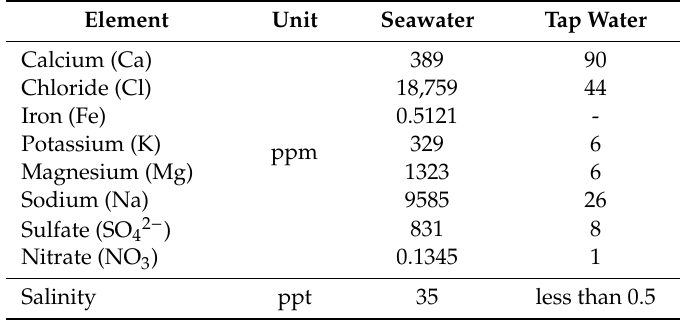
Table 3. Chemical composition of seawater compared to tap water